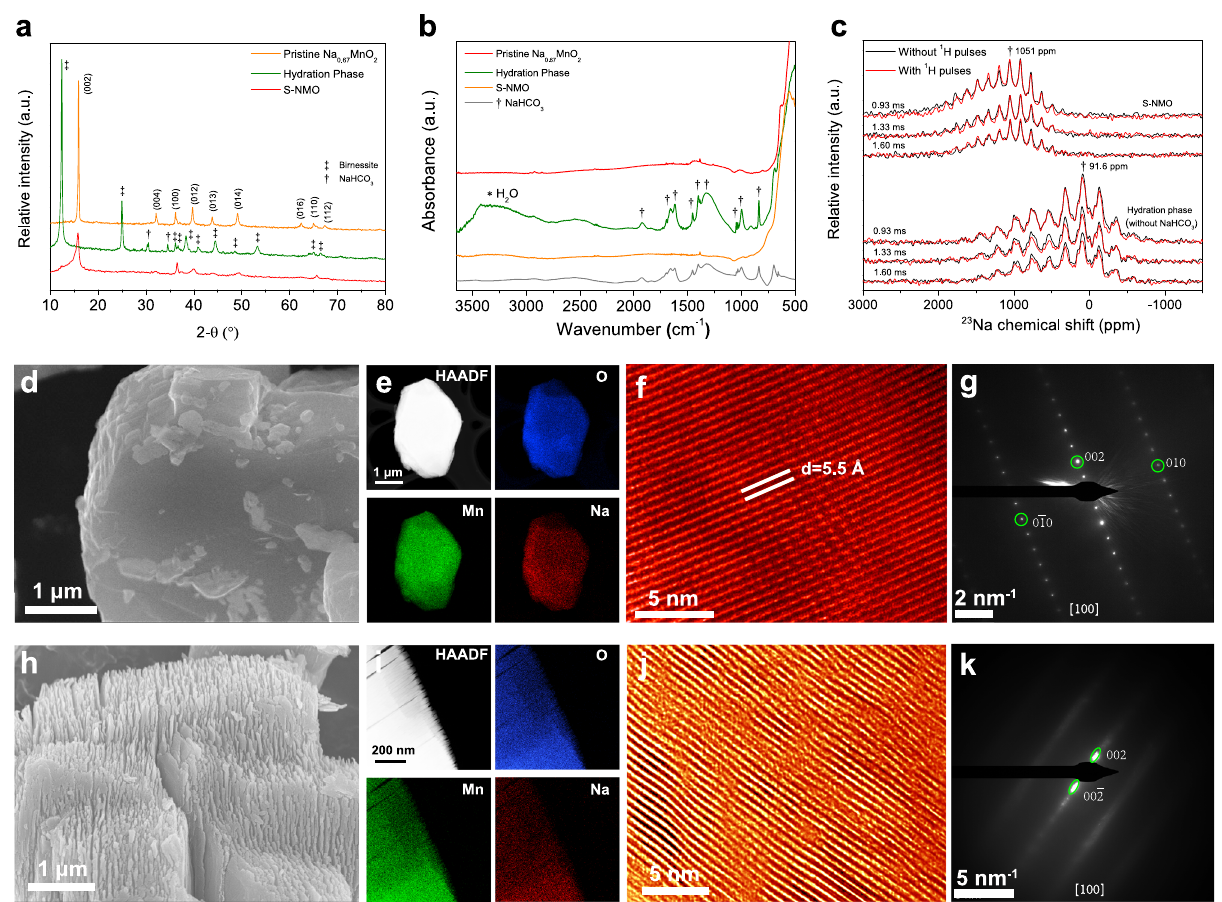
Fig. 3 Structural characteristics of S-NMO. a XRD patterns and b FTIR spectra of pristine Na 0.67 MnO 2 , S-NMO, and hydration phase. c 23 Na{ 1 H}